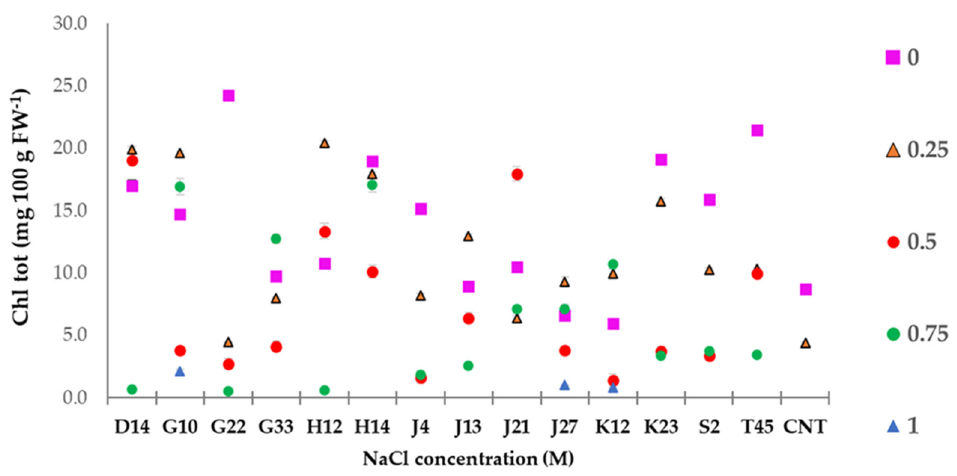
Figure 5. Contents of total chlorophylls (Chl tot ) estimated in leaves of inoculated and uninoculated plants without (0 M NaCl) and with salt stress induction (0.25 M, 0.5 M, 0.75 M, 1 M NaCl) (n = 3).